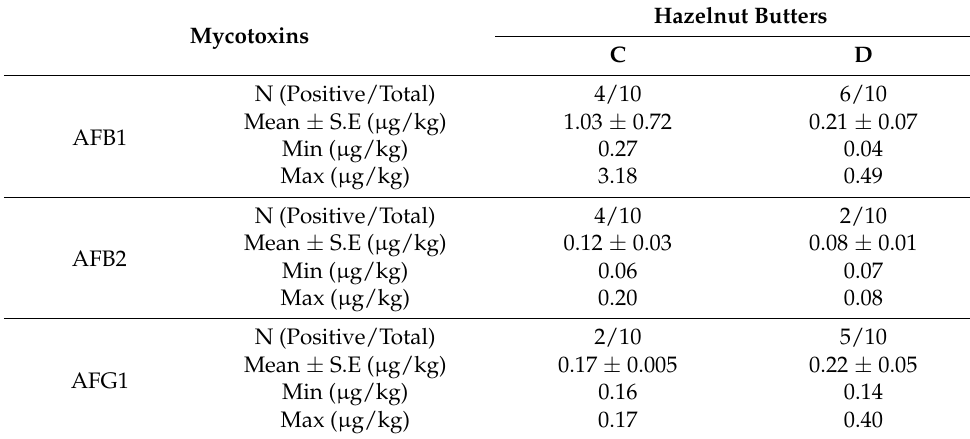
Table 2. Mycotoxin mean ± S.E, as well as the min and max data of positive hazelnut butter